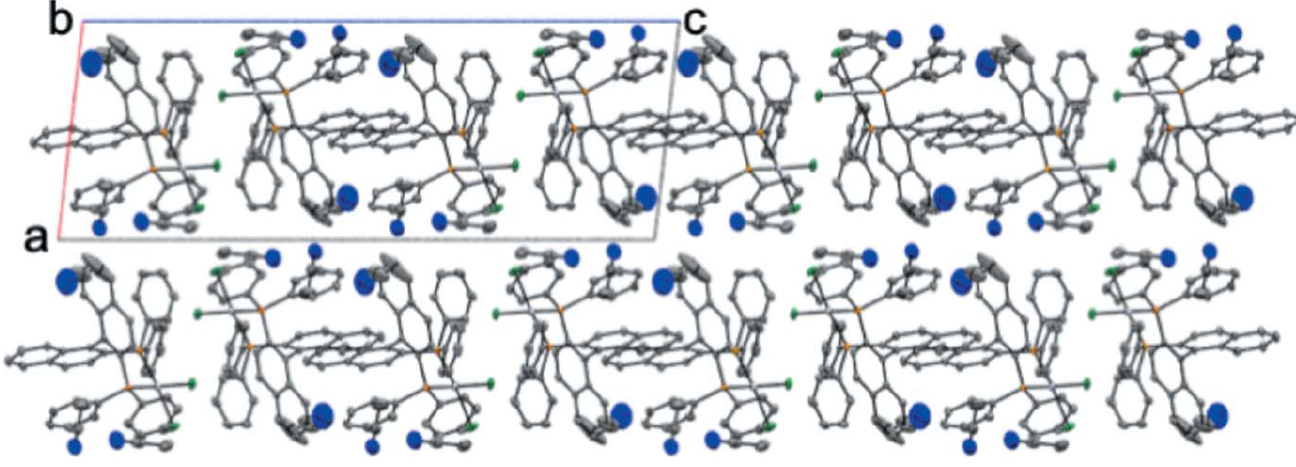
Figure 5 A projection showing the unit-cell contents and packing of ( rac BINAP)PtCl 2 . Displacement ellipsoids are shown at 50% probability level. Hydrogen atoms are omitted for